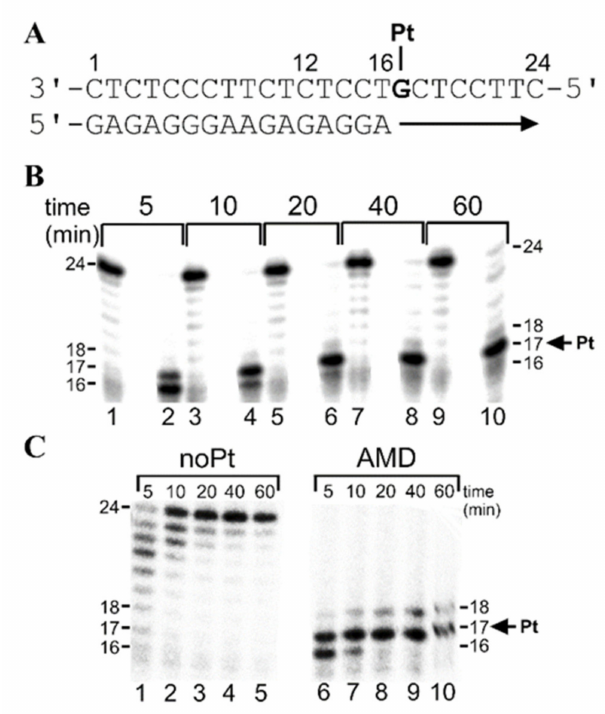
Figure 3. Translesion DNA synthesis by KF − and pol η on the 16-mer / 24-mer primer–template duplex non-modified or containing a single, monofunctional adduct of AMD in the presence of all four dNTPs (“standing start” DNA synthesis) for various time intervals (time points of 5–60 min are shown above the gels). The sequence of the primer–template is shown in ( A ); the position of the platinated G residue is indicated. Representative images of the DNA polymerase reaction products resolved on 15% polyacrylamide (PAA) gel are shown in ( B ) for DNA synthesis by KF − in the presence of 25 µ M of each of the four dNTPs and in ( C ) for DNA synthesis by pol η in the presence of 100 µ M of each of the four dNTPs. Lanes shown in ( B ): 1, 3, 5, 7, 9, undamaged template; 2, 4, 6, 8, 10, the template containing the single, site-specific monofunctional adduct of AMD. Lanes shown in ( B ): 1–5, noPt, DNA synthesis using an undamaged template; 6–10, AMD, DNA synthesis using the template containing single, monofunctional adduct of AMD. The pause sites (the product lengths) are shown on the right or left side of the